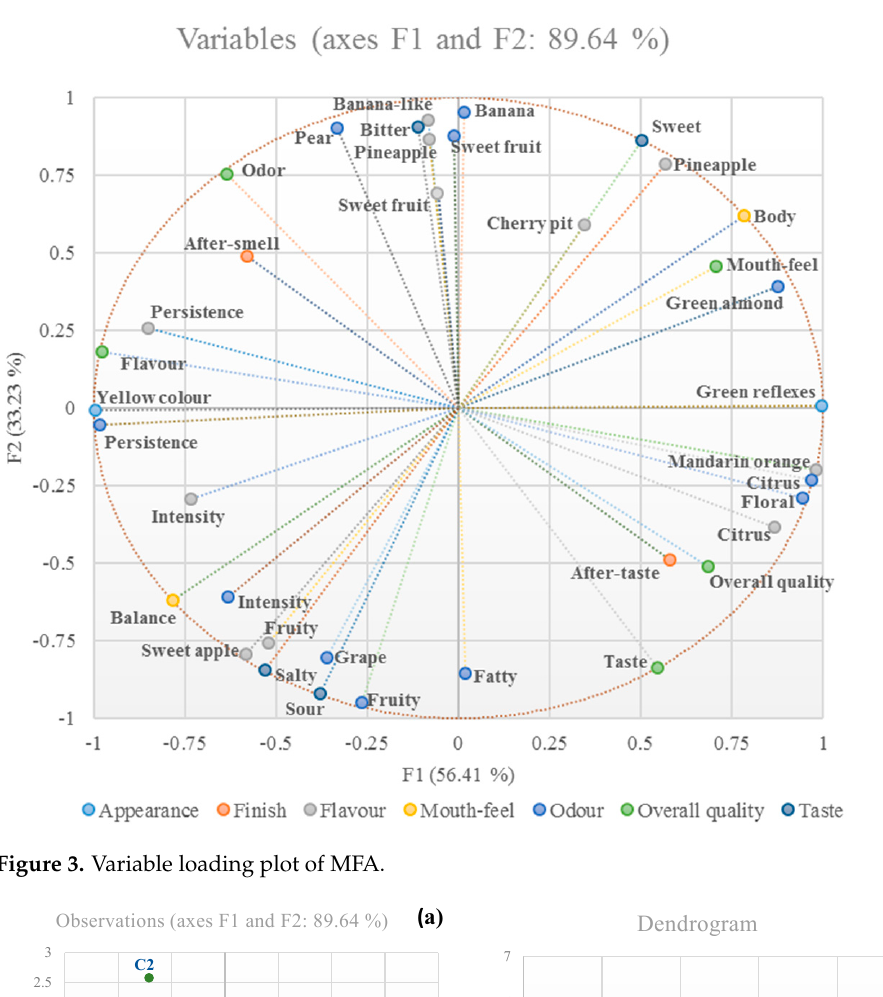
Figure 3. Variable loading plot of MFA.